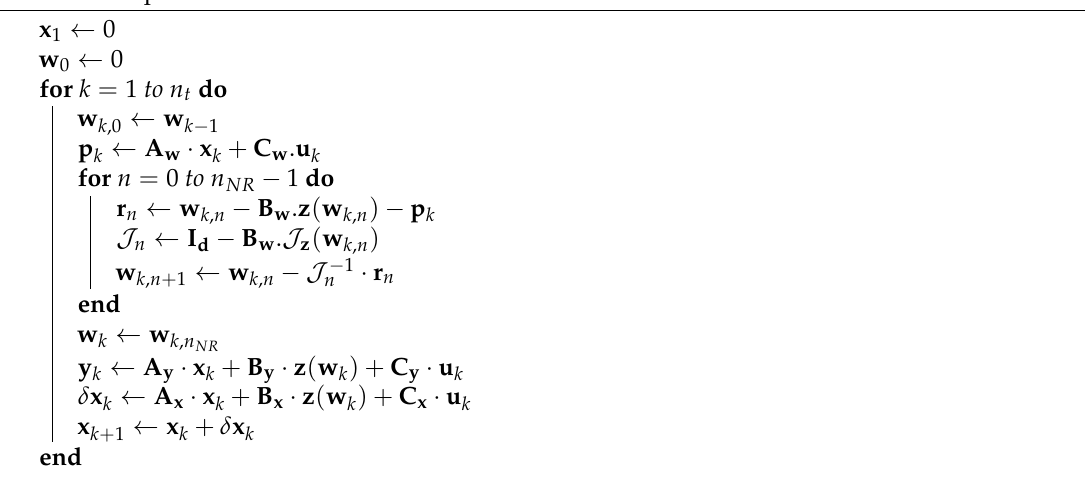
Algorithm 2: Simulation, with n t the number of time-steps and n NR the (fixed) number of Newton–Raphson